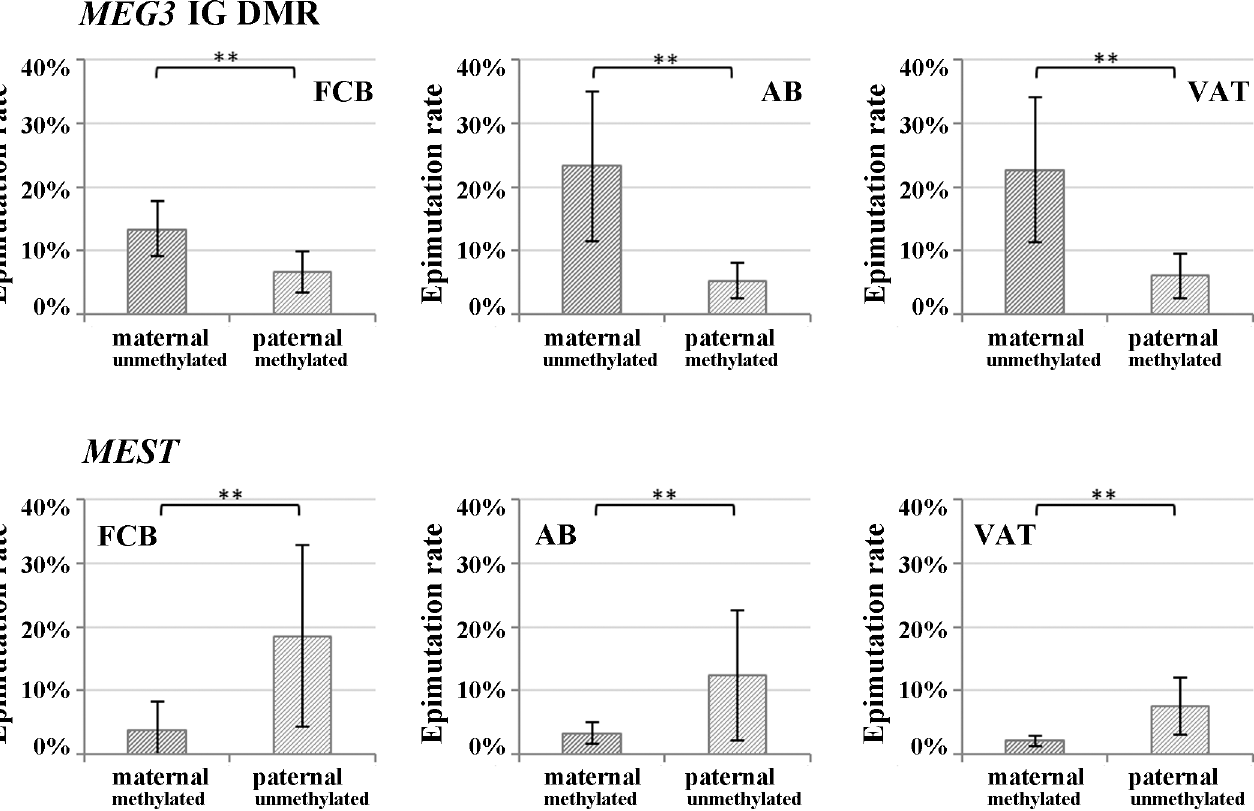
Fig 2. Parental allele-specific epimutation rates of the MEG3 IG DMR and the MEST promoter. The percentage of alleleswith > 50% aberrantly (de)methylated CpGs was deminedby DBS with the Roche GSJunior in FCB, AB, and VAT samples. The unmethylated allelesof the paternally imprinted MEG3 and the maternallyimprinted MEST genes displayedsignificantly higherepimutation rates than the methylatedalleles.